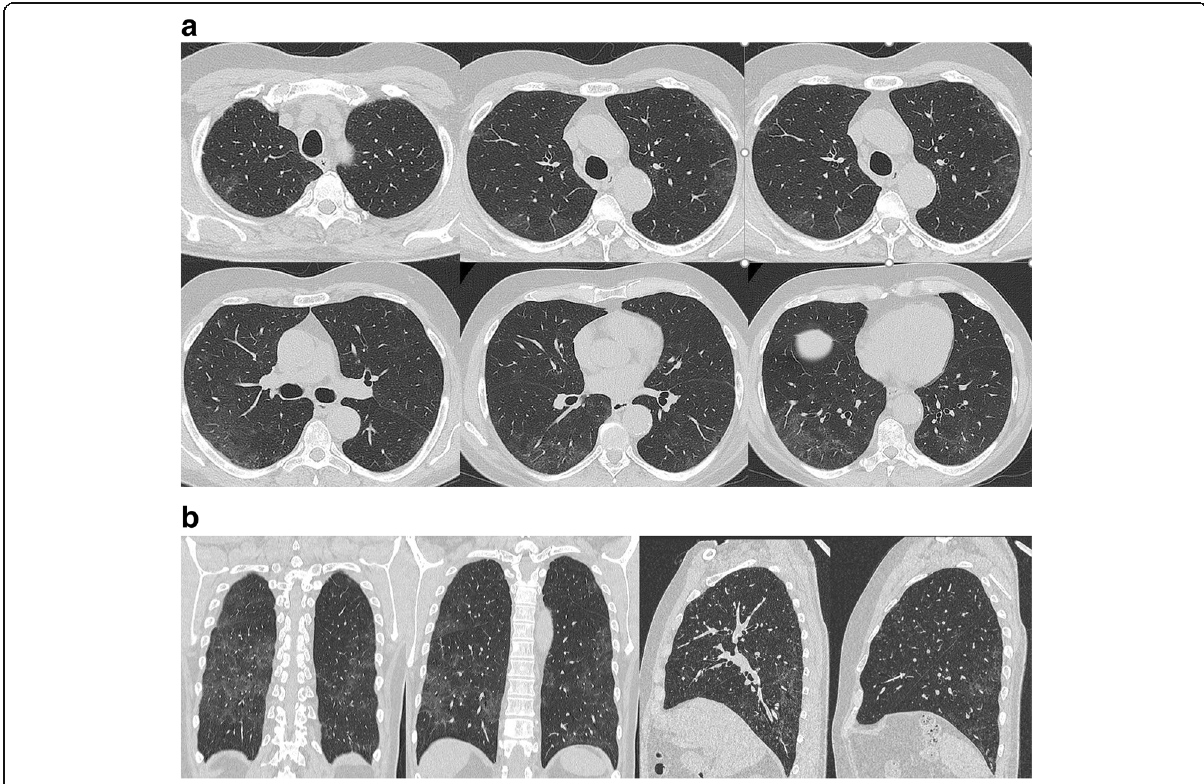
Fig. 2 Chest CT. In ( a ) on axial floor. In ( b ) coronal and sagittal floor. There are multiple bilateral peripheral ground-glass areas, more evident at basal and right, but present at the top of lungs too associated with the crazy-paving pattern, with the prevalence of interlobular e intralobular thickening compared to the ground-glass pattern. There are no evident pulmonary consolidations and/or mediastinal lymphadenopathies